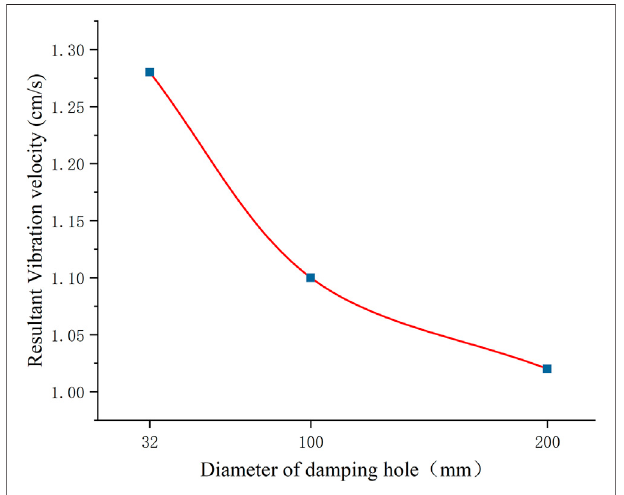
FIGURE 16 | The peak resultant vibration velocity response of Line 3 under the different diameters of damping hole.